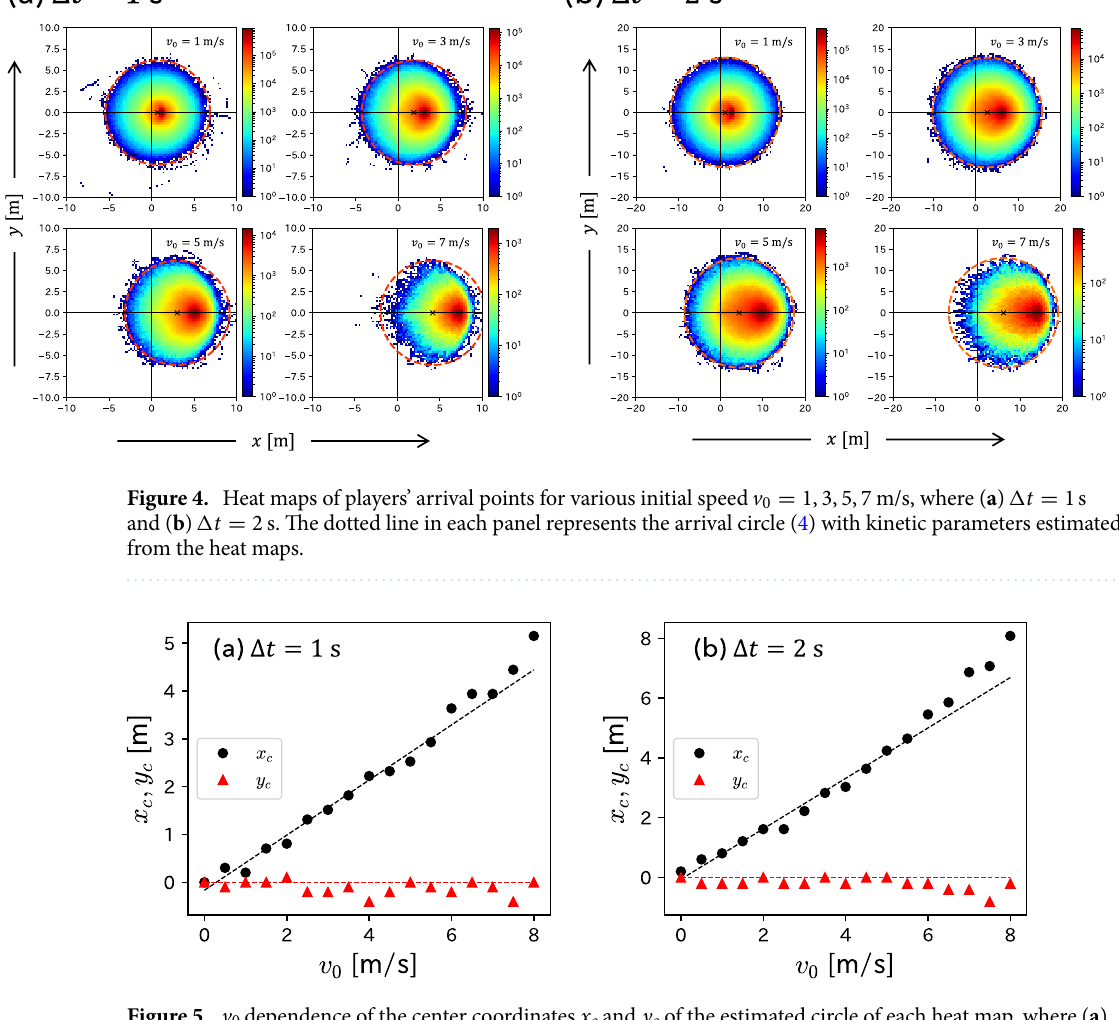
Figure 5. v 0 dependence of the center coordinates x c and y c of the estimated circle of each heat map, where ( a ) (cid:31) t = 1 s and ( b ) (cid:31) t = 2 s. The dotted lines in each panel represent the regression line for points where v 0 ≤ 6 m/s.